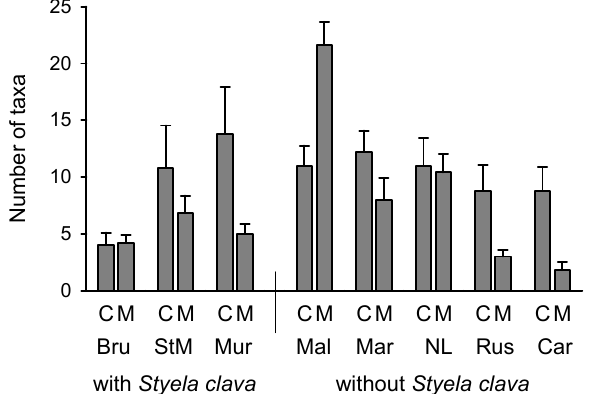
Figure 3. Taxonomic richness (±SE) of sediment macroinvertebrates sampled inside and outside mussel leases in bays with and without Styela clava . Table 4. DISTLM (Distance-based multivariate analysis) results testing fixed effects Bay type and Position on sediment macrobenthic assemblages using parameters ( a ) abundance, ( b ) biomass, and ( c ) productivity. Data for all 3 parameters were √ -transformed prior to analysis. Statistically signifi- cant effects are indicated in bold.